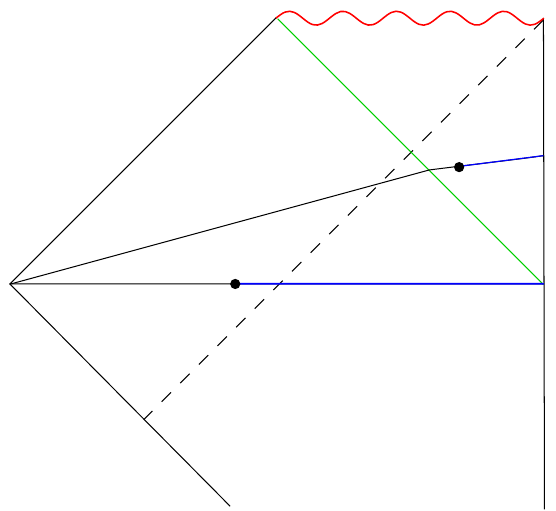
Figure 5 . Operators in Cauchy slices that either cross a shock or do not. If the operator’s dressing crosses no shocks | but the full Cauchy slice does | we can not use step 1 to remove said shock without (cid:12)rst using step 2 to move the operator to a di(cid:11)erent Cauchy slice which does not cross the shock.